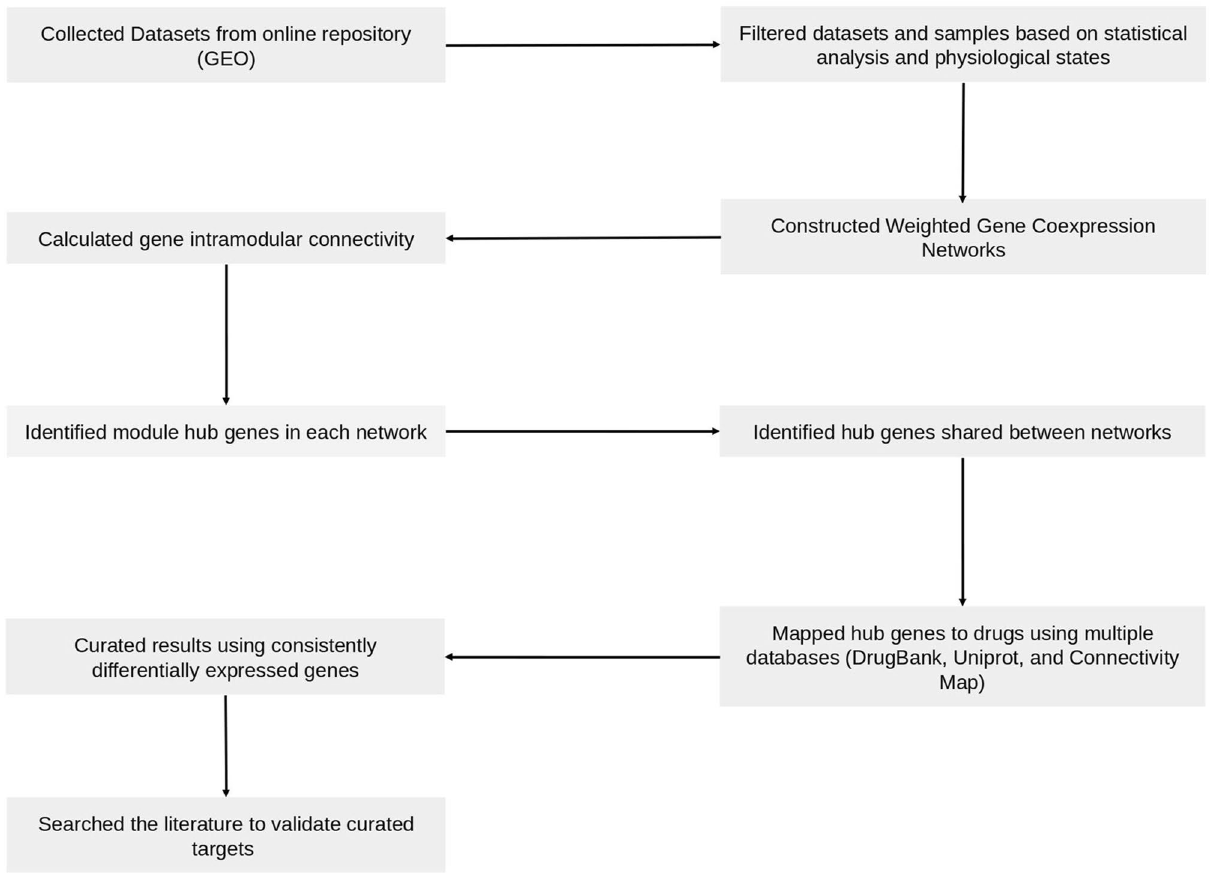
Figure 1. General workflow to construct gene coexpression network to predict potential drug